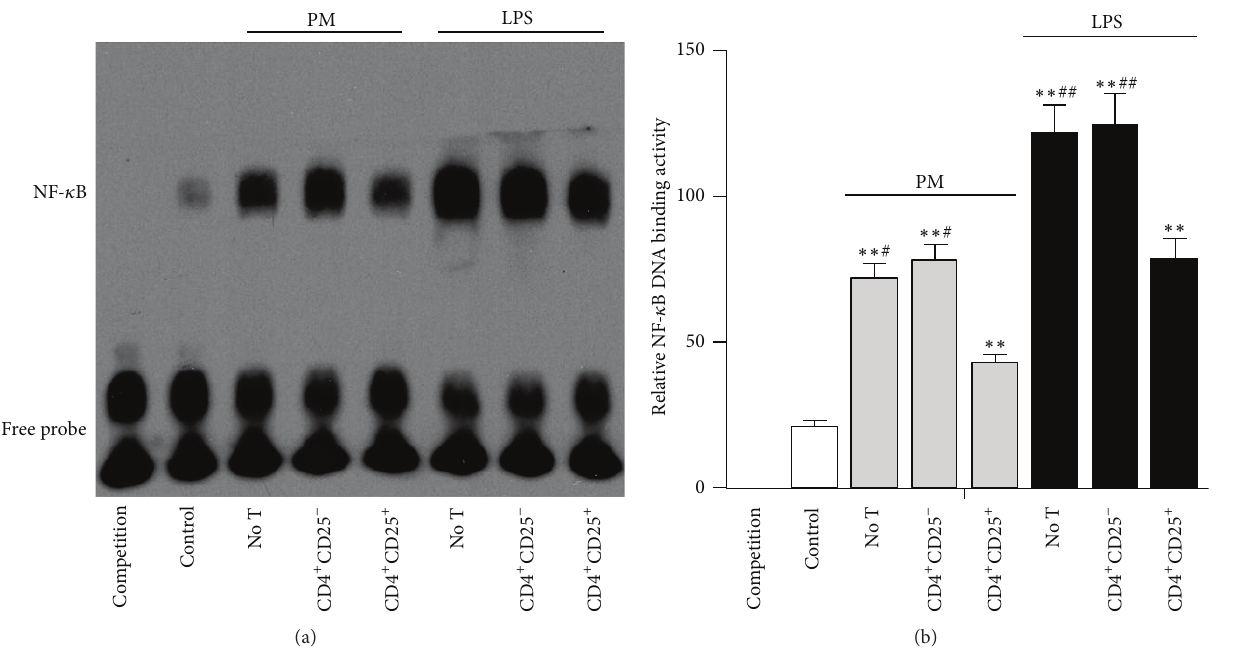
Figure 8: Tregs downregulate NF- 𝜅 B activation in HUVECs impaired by PM. The electrophoretic mobility shift assay (EMSA) was conducted with nuclear proteins isolated from different HUVEC cultures to detect the NF- 𝜅 B activity. (a) Representative EMSA results. (b) The DNA- bindingactivityofNF- 𝜅 Bindifferentgroupsdeterminedbytherelativemeasurementmethod.Dataareexpressedasmeans ± SEM. ∗ indicates no T, CD4 + CD25 − , or CD4 + CD25 + versus control; # indicates no T or CD4 + CD25 − versus CD4 + CD25 + . ∗∗ 𝑃 < 0.01 , # 𝑃 < 0.05 , and ## 𝑃 < 0.01 . Experiments were repeated 4